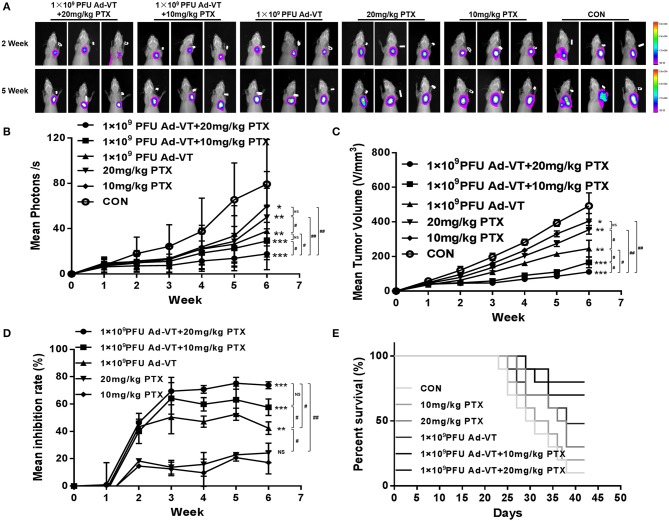
Effect of recombinant adenoviruses on breast cancer in a BALB/c nude mouse model. (A,B) The xenograft models were established via subcutaneous injection of MDA-MB-231-LUC cells (1 × 107/100 μl) into the right axil of the mice (n = 10 per group). In vivo bioluminescent imaging was used to continuously monitor changes in tumor bioluminescence intensity. (C,D) Length and width of xenograft tumors measured weekly for 6 weeks using Vernier calipers. The average tumor inhibition was calculated using the formula: (1 – treatment group tumor weight / control tumor weight) × 100%. (E) After successfully establishing xenograft models in nude mice, the mice survivals were recorded every day for 6 weeks. The average tumor inhibition of the 1 × 109 PFU/100 μl Ad-VT + the 20 mg/kg paclitaxel treated group was significantly higher than that of the other groups and reaching 73.1%. Similarly, the survival rate of the 1 × 109 PFU/100 μl Ad-VT + the 20 mg/kg paclitaxel treated group was also the highest, reaching 80%. #p < 0.05, ##p < 0.01. (*p < 0.05, **p < 0.01, ***p < 0.001 vs. Control or 10 mg/kg PTX treated group).